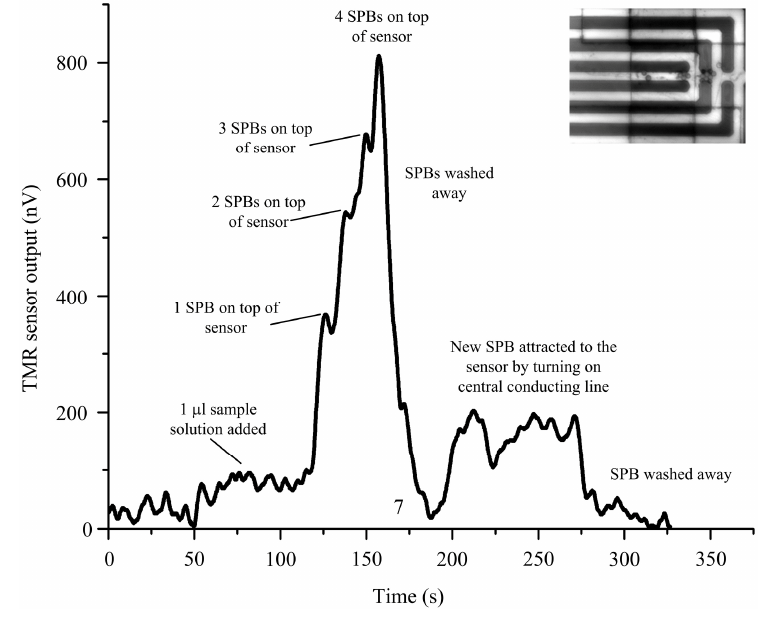
Figure 7. Manipulation and detection of magnetic beads by the micro-chip.